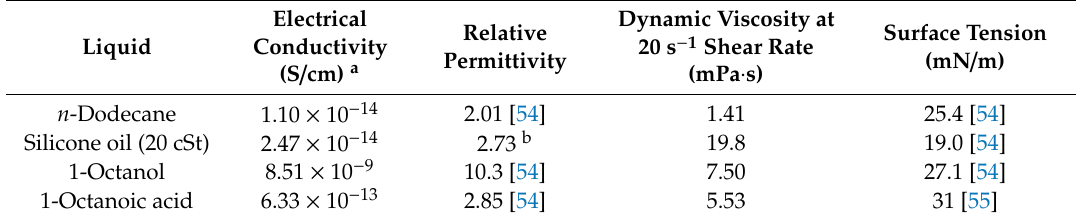
Table 1. Physical properties of the neat liquids (present data at 24.0 ± 0.5 ◦ C; literature data at 25 ◦ C).